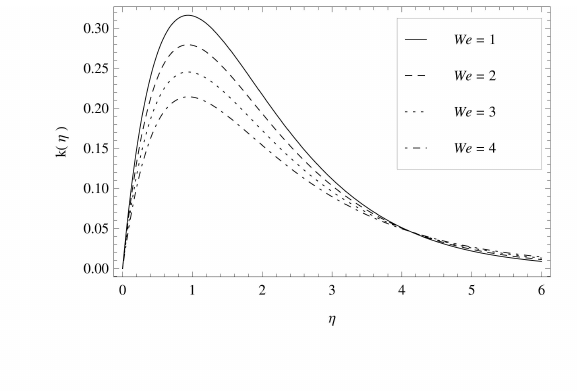
Fig. 15: The influence of a parameter M on k ( η ) for λ = 0.3, We = 0.1, α = 1, f = 0.9 and (cid:126) = −0.01 w